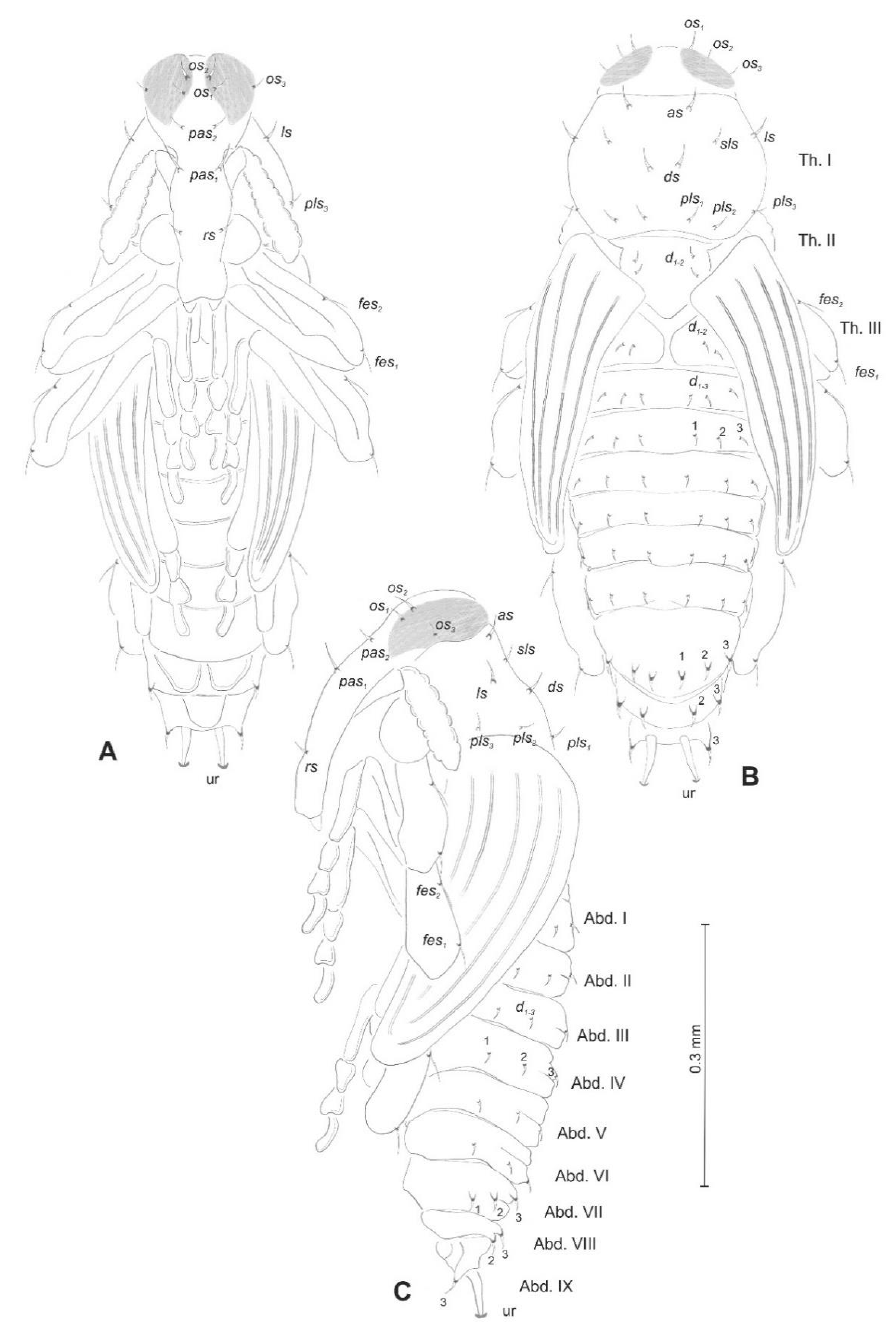
Figure 13. Euryommatus mariae pupa, habitus, and chaetotaxy. ( A ) Ventral view; ( B ) dorsal view; ( C ) lateral view (Th. I–III—pro-, meso-, and metathorax, Abd. I–IX—abdominal segments 1–9, ur—urogomphus, setae: as —apical, d —dorsal, ds —discal, fes —femoral, ls —lateral, os —orbital, pas —postantennal, pls —posterolateral, rs —rostral, sls —super lateral).